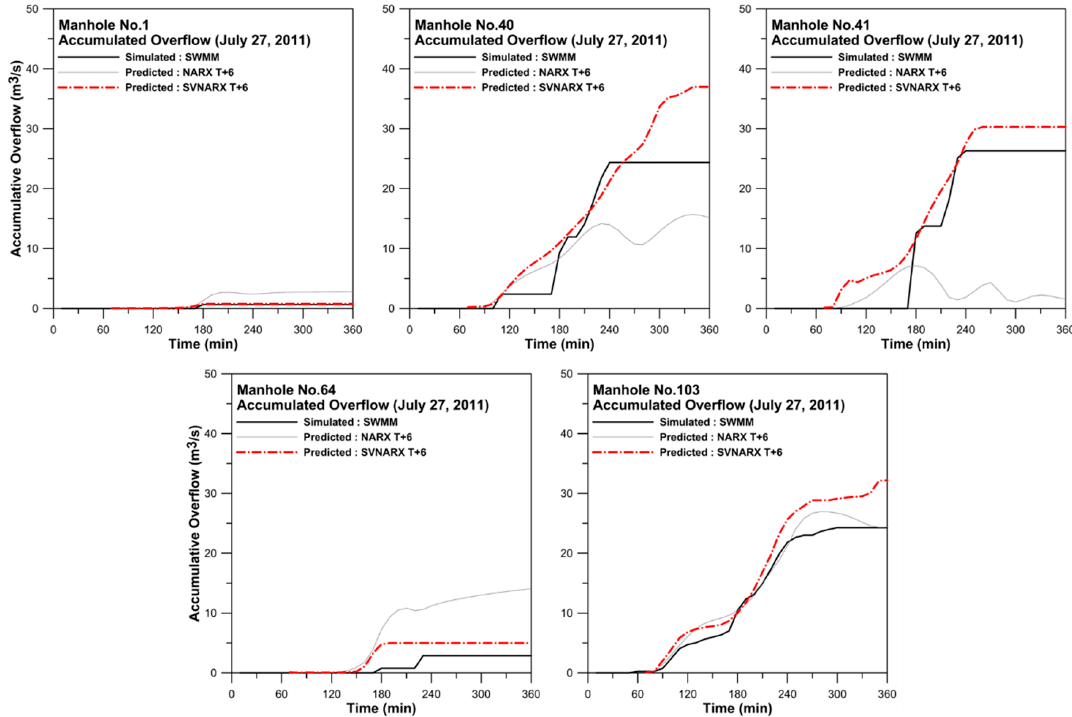
Figure 9. Prediction results from each manhole in study area.